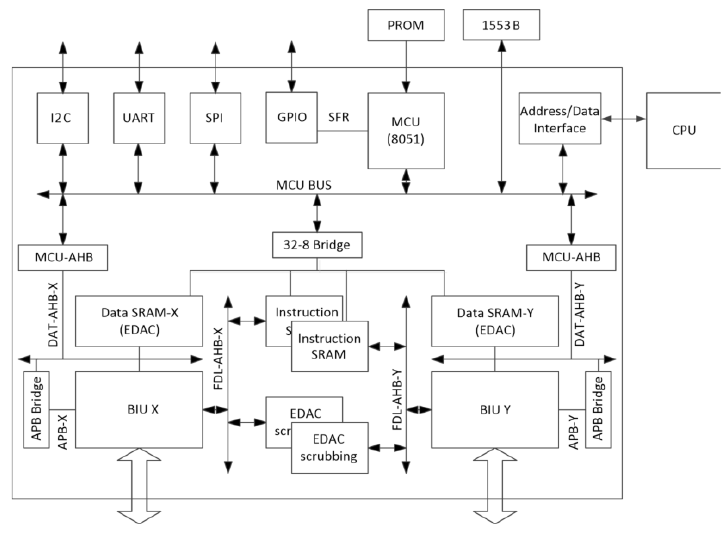
Figure 2. Architecture of the proposed bus